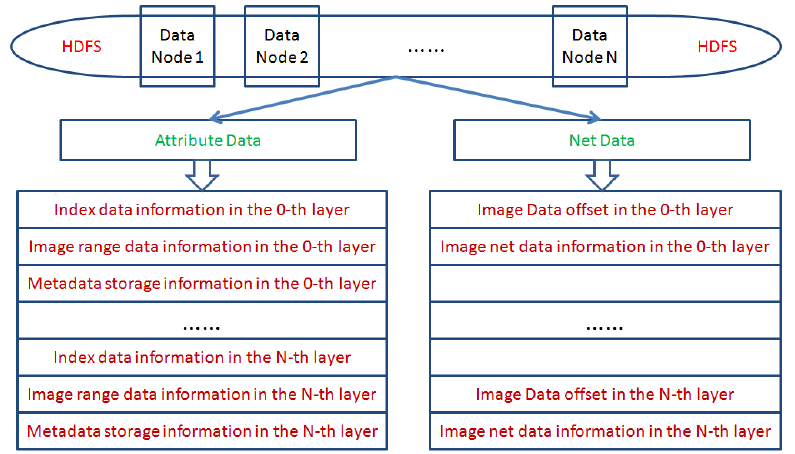
Figure 3. Two types of data for distributed storage. HDFS: Hadoop distributed file